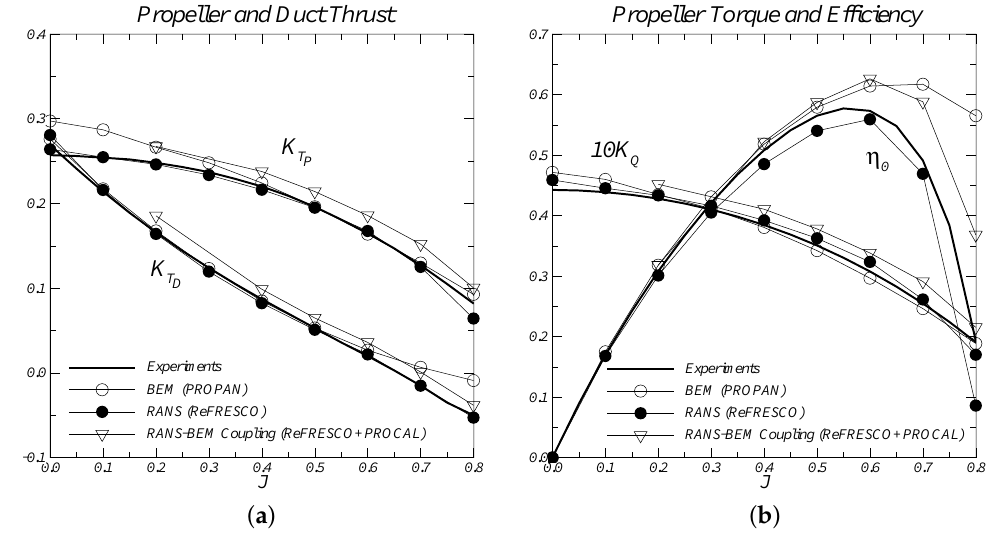
Figure 15. Comparison between numerical and experimental data from open-water tests. Propeller and duct thrust ( a ); Propeller torque and open-water efficiency ( b